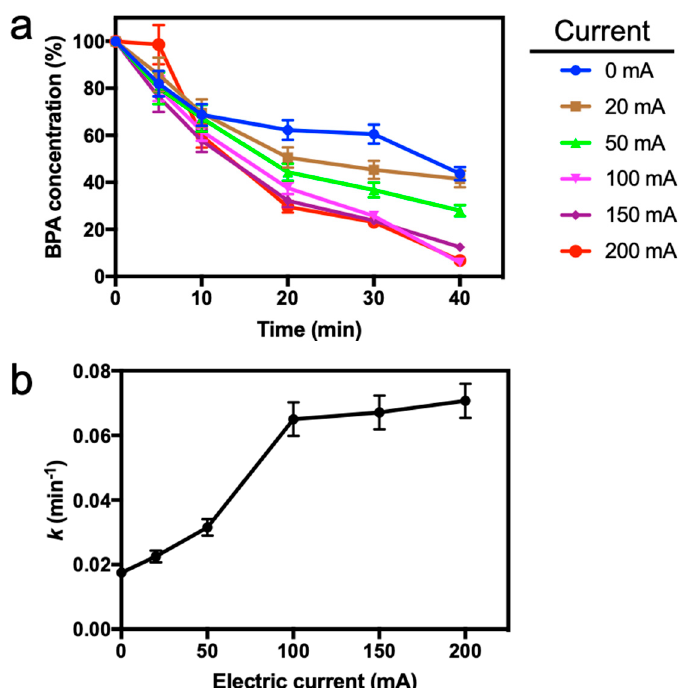
Figure 5. Effect of electric current on the BPA removal by the electro/Mn(II)/sulfite process. ( a ) BPA removal and ( b ) pseudo first-order removal constant versus electric current. Reaction conditions: 0.2 mM Mn(II), 2 mM sulfite, 5 mM sulfate as supporting electrolyte, 10 µ M BPA, 0–200 mA electric current, and pH 6.